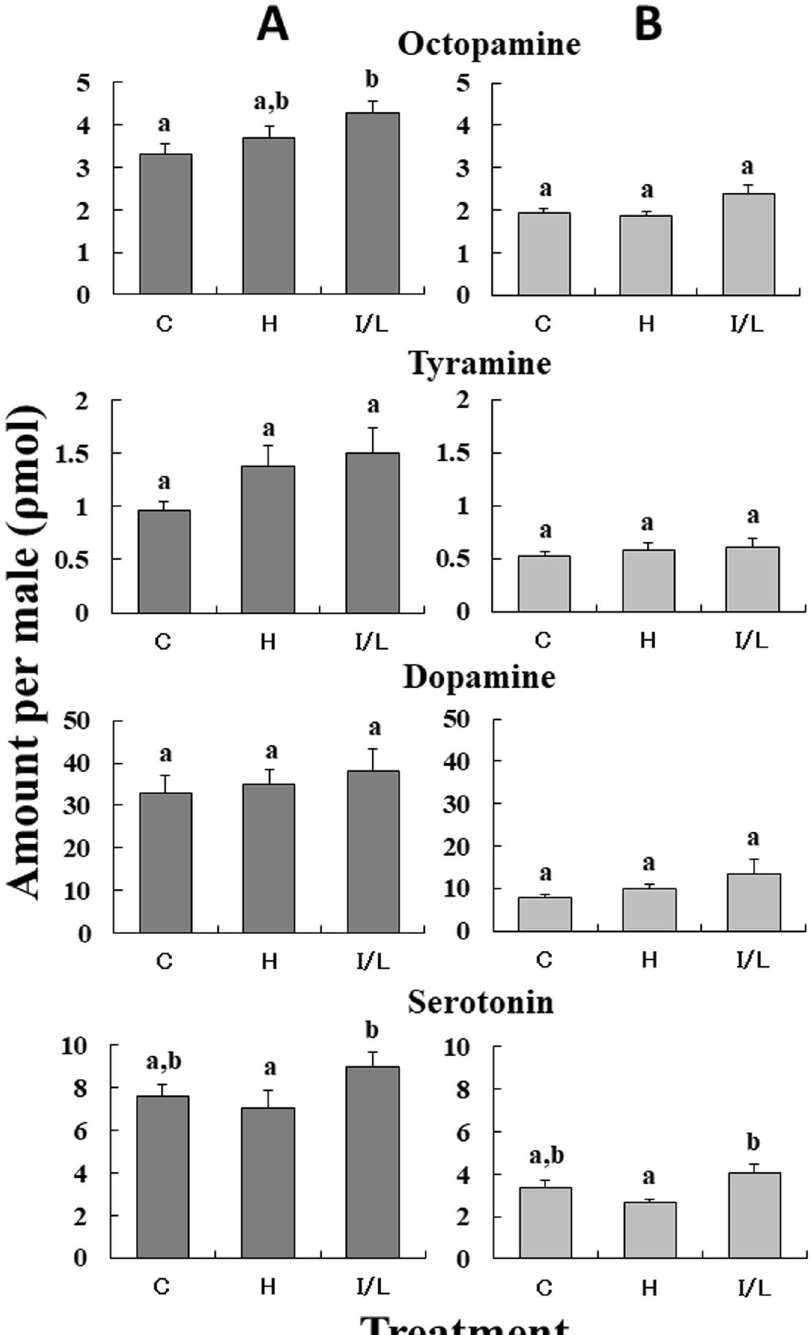
Figure 6. Amounts of biogenic amines (mean + SE) present in the brain ( A ) and thoracic ganglia ( B ) of Parantica sita males that were fed heliotrine (H; 1.5 mg each, N = 32) or I/L (1.5 mg each, N = 37 for brain and N = 35 for thoracic ganglia). C: control (PA-unfed) males ( N = 35). Values unmarked by the same letters (in the same chart) are significantly different ( p < 0.05 for octopamine and